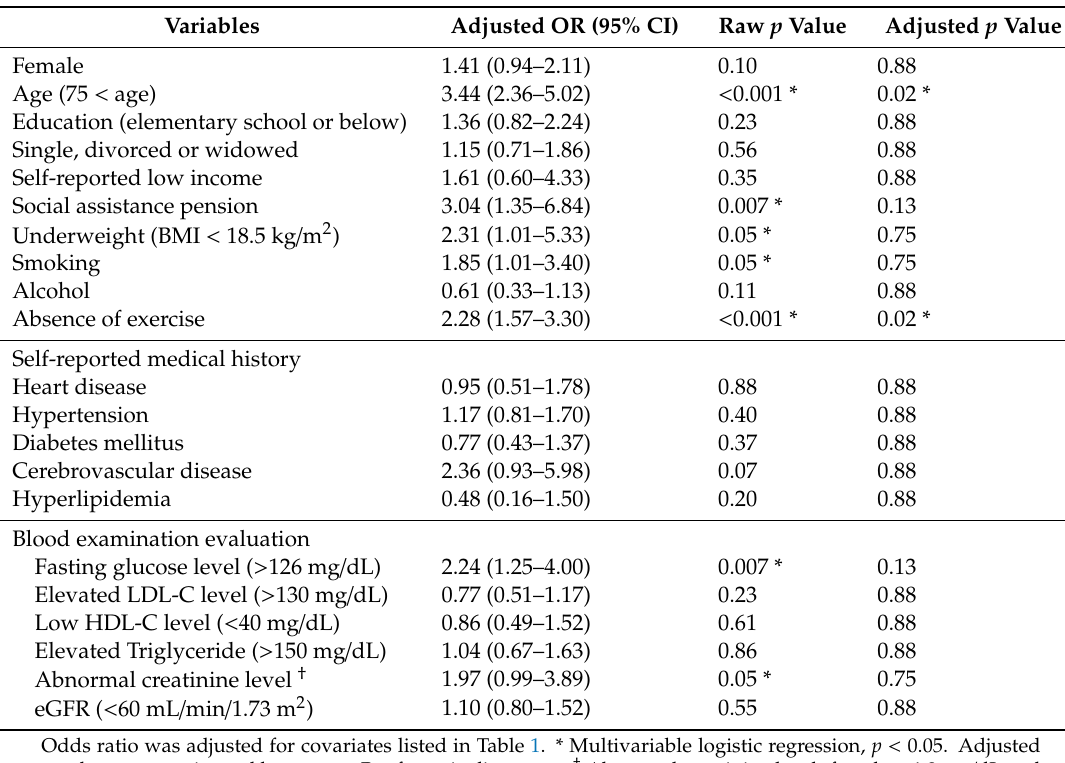
Table 2. Multivariable logistic regression model in prediction of